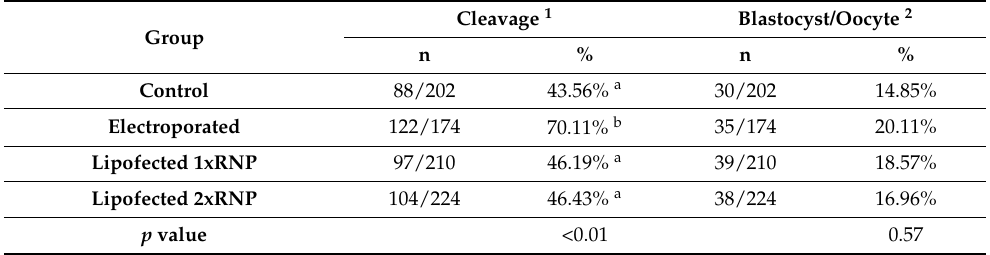
Table 5. Embryo development parameters (cleavage and blastocyst formation rates) after electro- poration or lipofection with different concentrations of the CRISPR/Cas9 system. Variables were analyzed via the non-parametrical Kruskal–Wallis test. When significant differences were